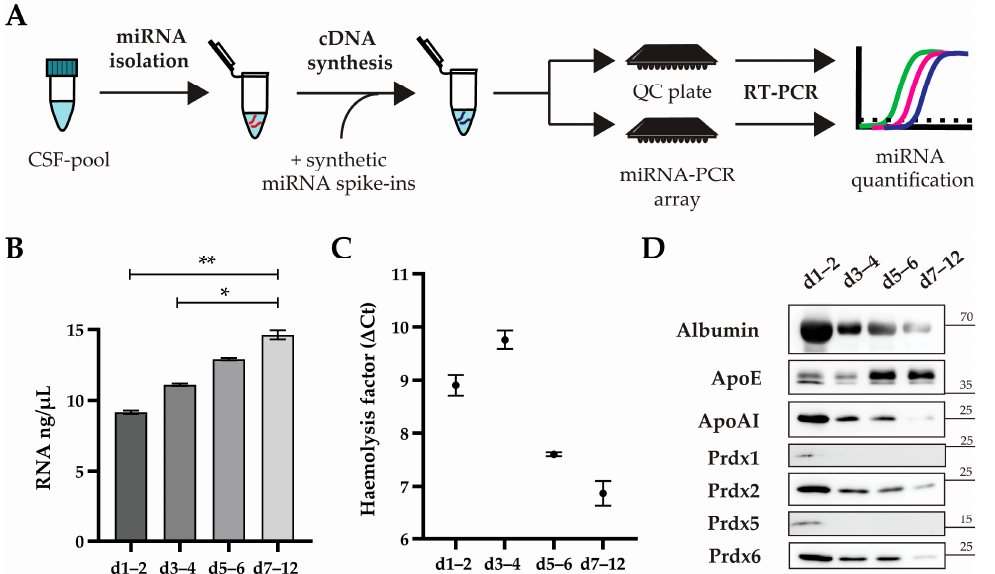
Figure 2. microRNA (miRNA) is detected in all four cerebrospinal fluid (CSF) pools along with haemolysis and plasma proteins. ( A ) The study overview comprising miRNA isolation, addition of miRNA spike-ins before cDNA synthesis, and miRNA quantification by real-time PCR, with predesigned arrays containing primers for 87 target miRNAs (miRNA-PCR array) or miRNAs for a quality control (QC) plate. ( B ) miRNA was isolated from the CSF pool of indicated days (d) after severe traumatic injury, and RNA concentration was determined spectrophotometrically. The mean values of three miRNA isolations with standard deviations are shown. * p < 0.05 and ** p < 0.01 by one-way nested ANOVA analysis with Tukey’s post hoc test for multiple comparisons. ( C ) Haemolysis factor as determined by real-time PCR with cDNAs from indicated CSF pools applied to amplify haemolysis dependent and independent miRNAs on a QC plate. The mean values of three experiments with standard deviations are shown. ( D ) The immunodetection of depicted proteins in specified CSF pools after western blot. Protein sizes are designated in kilodaltons. Representative images are shown.